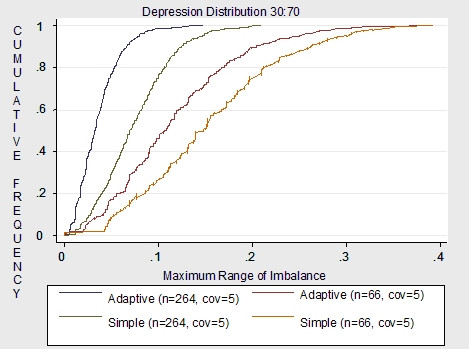
Non-stratifying factors: stratified simple vs. adaptive (5 covariates) for n = 66 and n = 264.